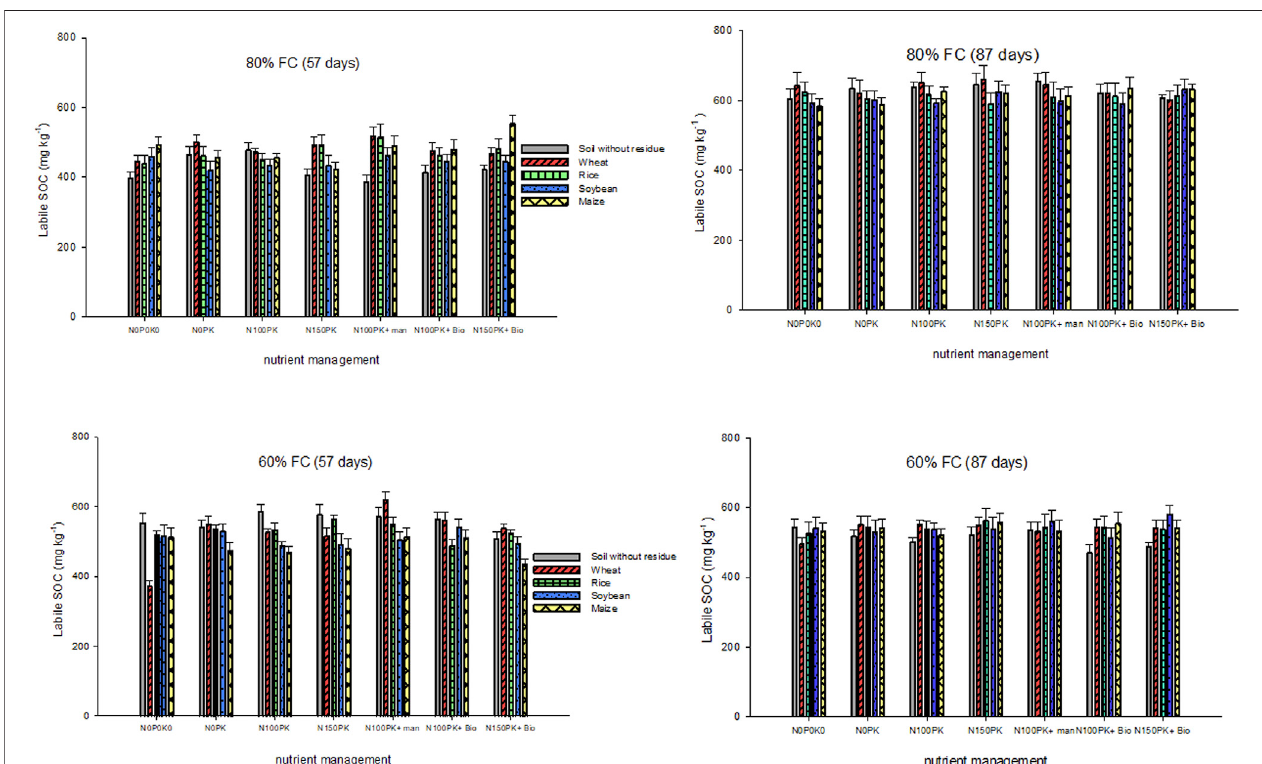
FIGURE 5 | Labile soil organic carbon (mg kg − 1 ) as in fl uenced by residue types, nutrients, and soil moisture after 57 and 87 days ofincubation. Details of labile soil organic carbon statistics are provided in Tables 3 , 6 .